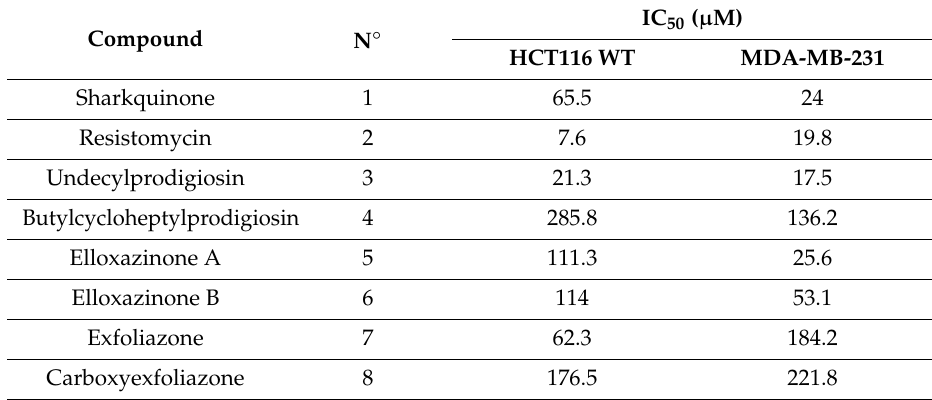
Figure 2. Effect of marine compounds on the viability of HCT116 and MDA-MB-231 cells. ( A , B ) The human colorectal and breast cancer cell lines were treated with various concentrations of the marine compounds for 24 h and viability was determined by methylene blue assay. Results correspond to three independent experiments. Error bars represent the SD values. ( 1 ) Sharkquinone, ( 2 ) resistomycin, ( 3 ) undecylprodigiosin, ( 4 ) butylcycloheptylprodigiosin, ( 5 ) elloxazinone A, ( 6 ) elloxazinone B, ( 7 ) carboxyexfoliazone, and ( 8 ) exfoliazone. Table 1. Half-maximal inhibition concentration (IC 50 ) values for marine compounds determined in vitro in the colorectal carcinoma HCT116 and triple negative breast cancer MDA-MB-231 cell lines, determined by methylene blue